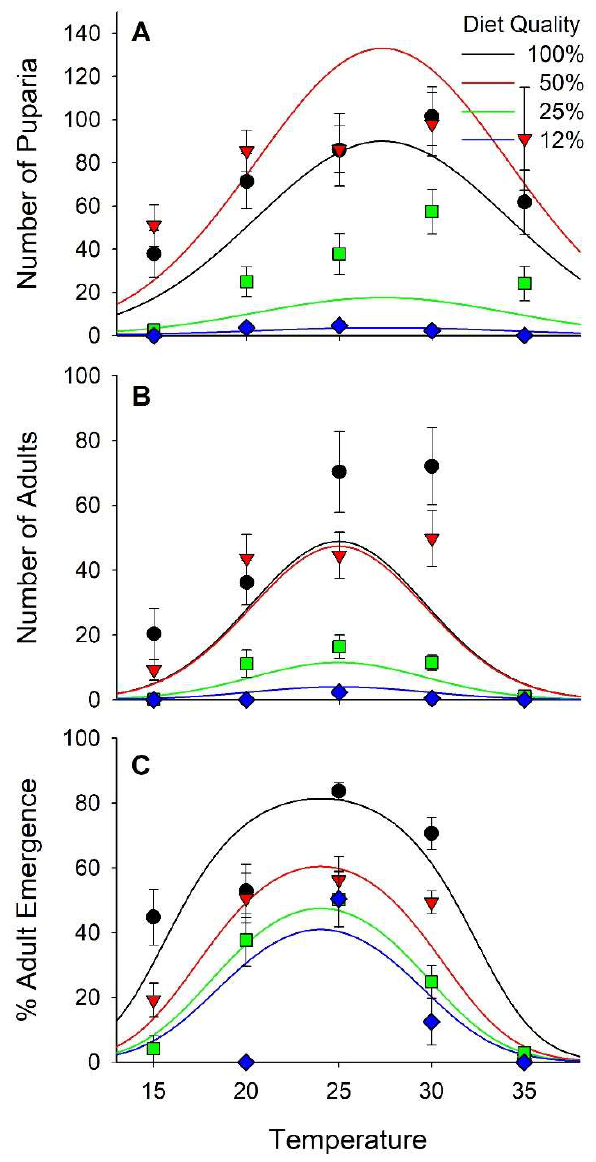
Figure 4. Number of puparia ( A ) and number of adults ( B ) per cup and percentage of the puparia from which adults successfully emerged ( C ). Each cup received ≈185 stable fly eggs.